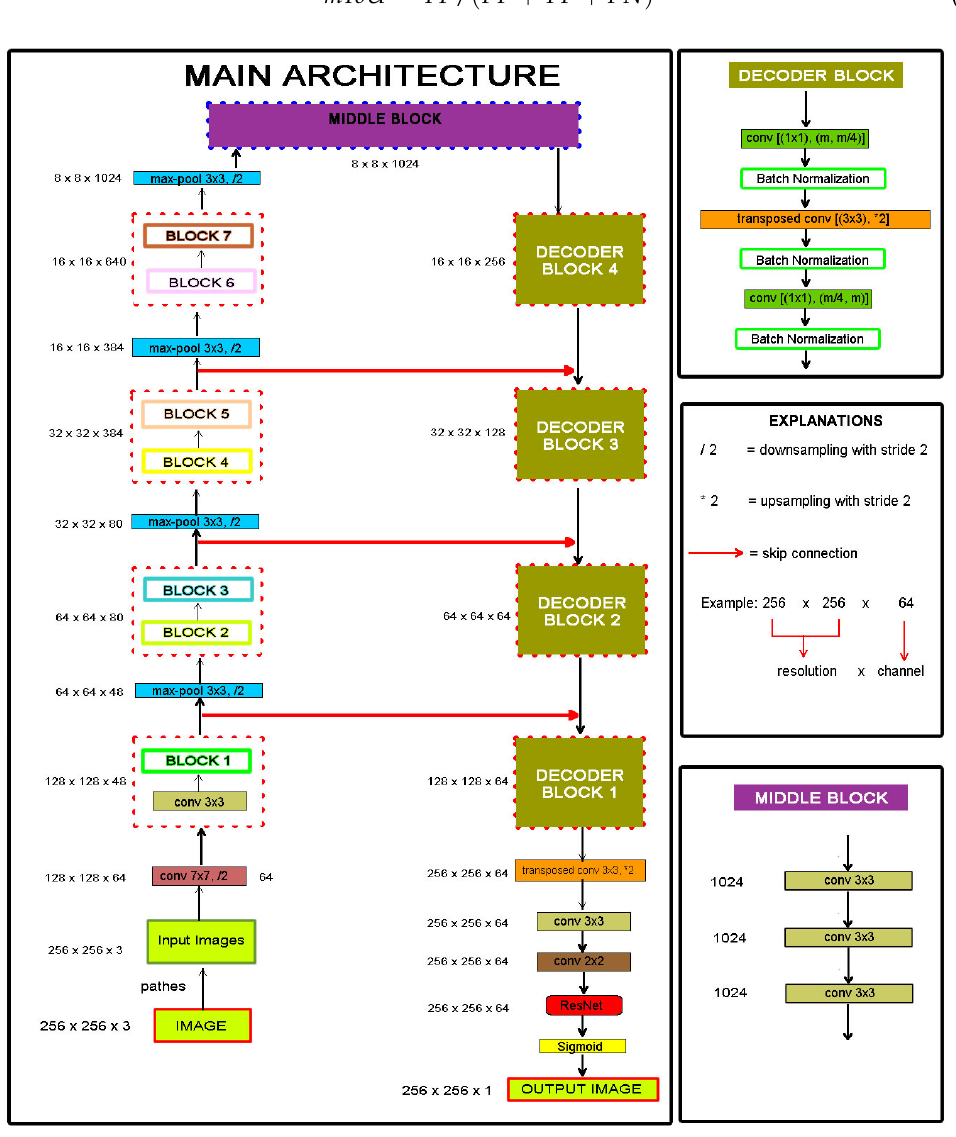
Figure 8. LinkNet-B7